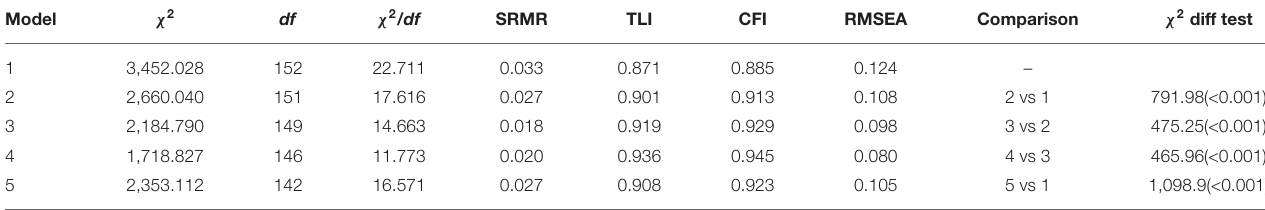
TABLE 3 | Confirmatory factor analyses in sample B ( N = 1,413).